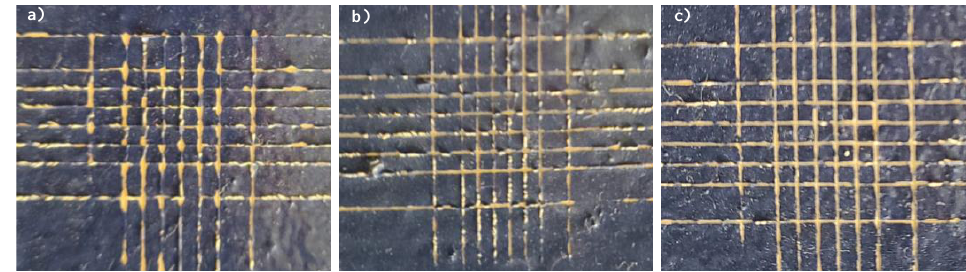
Figure 5. Adhesion cross-cut test of commercial topcoat H ( a ), HSM1 ( b ), and HSM5 topcoat ( c ).